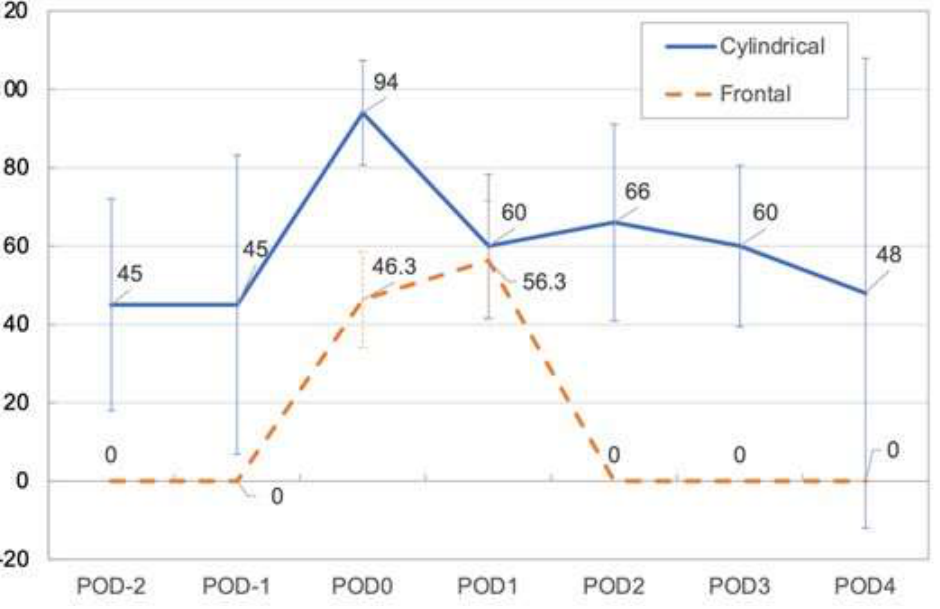
Figure 3. Mean opioid dose (Median morphine equivalent dose) in cylindrical and frontal illumination methods. Table 3. Maximum opioid dose and NRS and mean NRS changes.